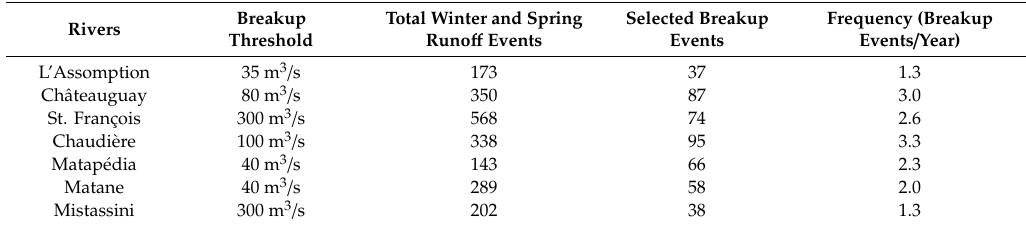
Table 2. Ice cover mobilization threshold, winter and spring runo ff events over 29 winters (all runo ff events and confirmed ice jams, both data sets presented in Figure 2), probable and confirmed dynamic breakup events (selected runo ff events in the yellow and red zones) and average annual breakup frequency for each studied river. Breakup Total Winter and Spring Selected Breakup Frequency (Breakup Rivers Threshold Runo ff Events Events Events /